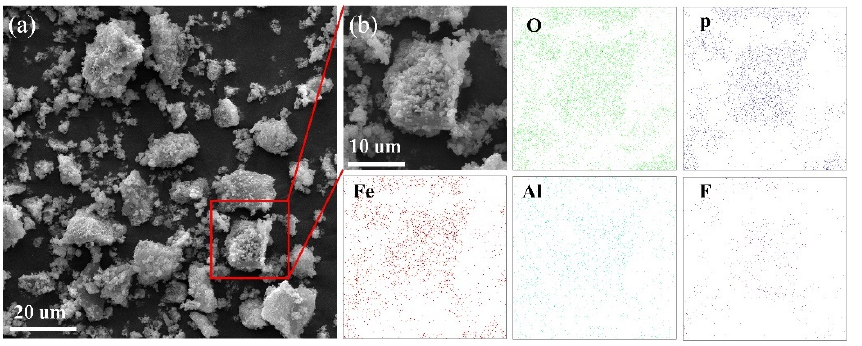
Figure 6. Scanning electron microscopy-energy-dispersive spectroscopy (SEM-EDS) spectra of precipitate under optimal conditions. (agitation rate = 400 rpm, reaction time = 5 min, reaction temperature = 25 °C, and final pH value 3.77). ( a ) SEM image of the precipitate; ( b ) Microstructure of the precipitate.